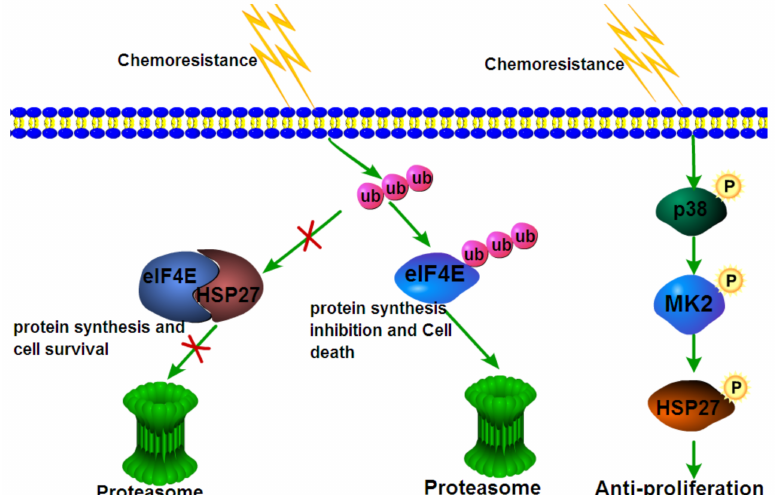
Figure 1. Schematic diagram summarizing the working models discovered so far regarding the biochemical mechanism by which HSP27 is involved in the chemoresistance of cancer cells on the basis of references [43,46], from which reprinted and adapted with permission was obtained. In the working model proposed by reference [43], HSP27 was found to interact with the transcrip- tion factor eIF4E, which can protect eIF4E from ubiquitination and ensuing protein degradation, thereby conferring cancer cell chemoresistance. In a working model from reference [46], activated or HSP27 phosphorylated by p38 can produce anti-proliferation effects, which renders cancer cells chemoresistant, as